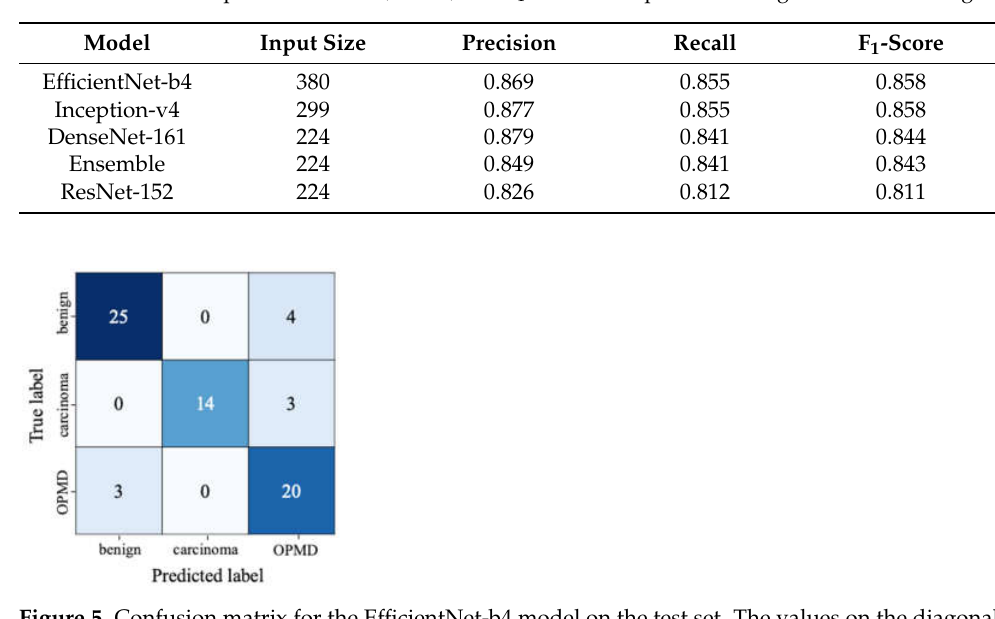
axis show the number of TP and TN predictions and the off-diagonal values show the number of FP